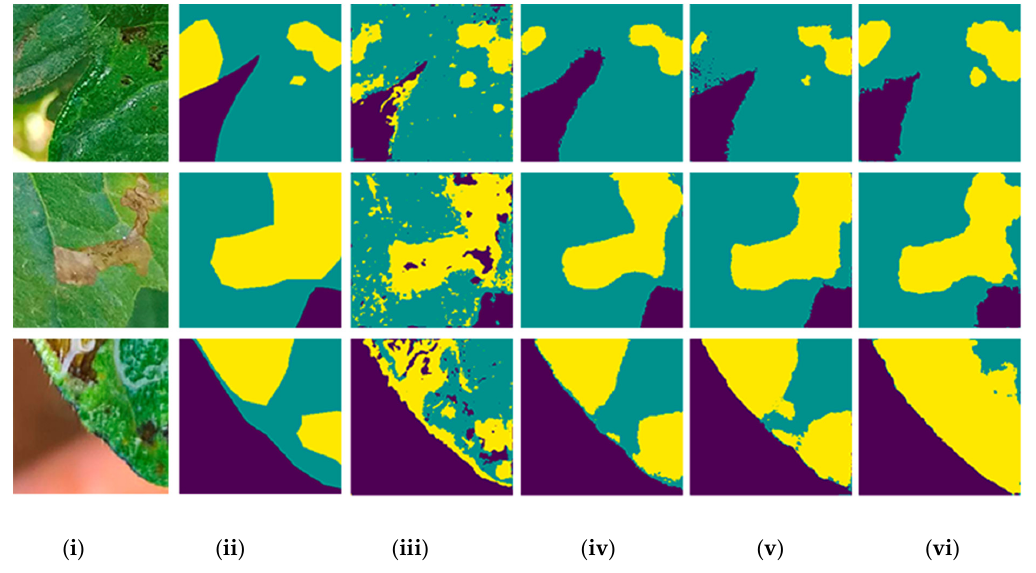
Figure 4. Visual comparison of the results of the multiclass semantic segmentation from the LinkNet model performed on the testing database. ( i ) Original image, ( ii ) reference annotation, ( iii ) VGG16, ( iv ) DenseNet121, ( v ) Inceptionv3, ( vi ) ResNet34. The background class is purple, the tomato leaf